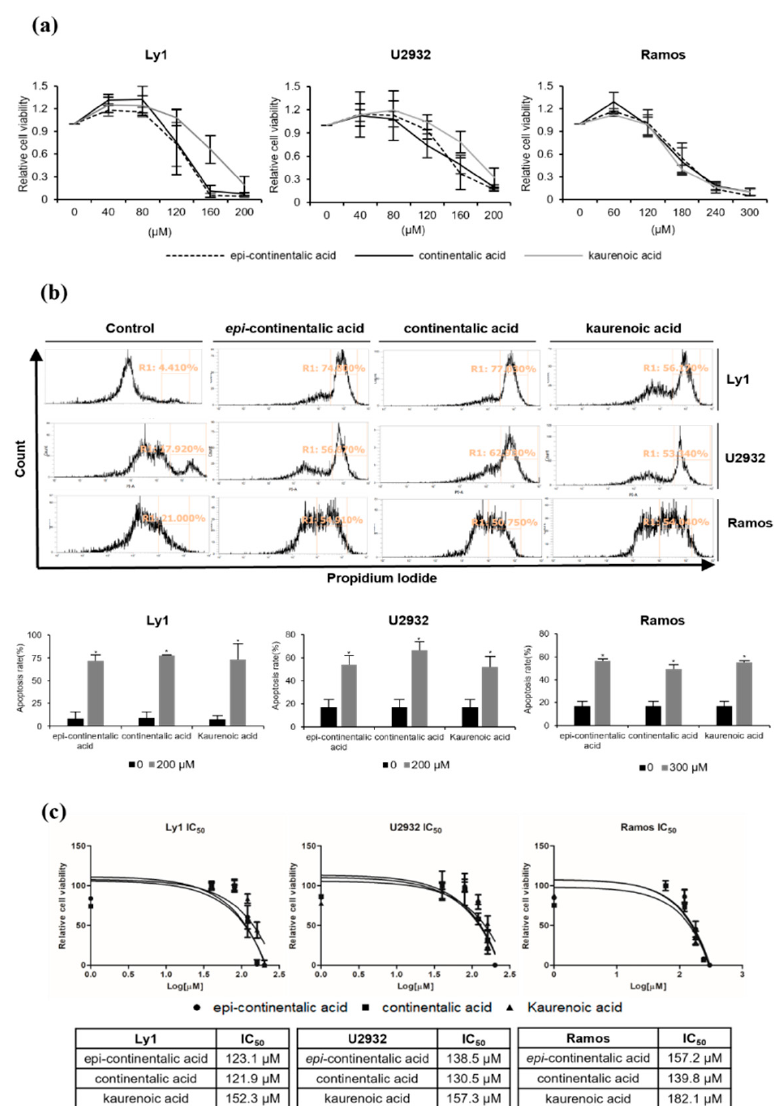
Figure 3. Epi -continentalic acid, continentalic acid, and kaurenoic acid induce apoptosis in human lymphoma cell lines. ( a ) Cell viability of Ly1, U2932, and Ramos was measured by MTS assay after treatment with epi -continentalic acid, continentalic acid, or kaurenoic acid for 24 h, as indicated. ( b ) Relevant cells were exposed to epi -continentalic acid, continenetalic acid, or kaurenoic acid for 24 h, as indicated, and the apoptotic rate was measured by PI staining followed by FACS analysis. The two-tailed Mann–Whitney test was used to calculate statistical significance (* p < 0.05). ( c ) The IC 50 values of epi -continentalic acid, continentalic acid, and kaurenoic acid in Ly1, U2932, and Ramos cells were calculated using GraphPad Prism 5